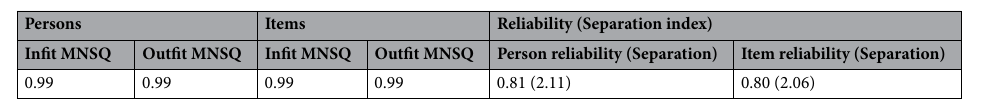
Table 4. Summary of the global fit statistics for person ability and item difficulty parameters for the SQVD. (MNSQ: Mean square statistics).